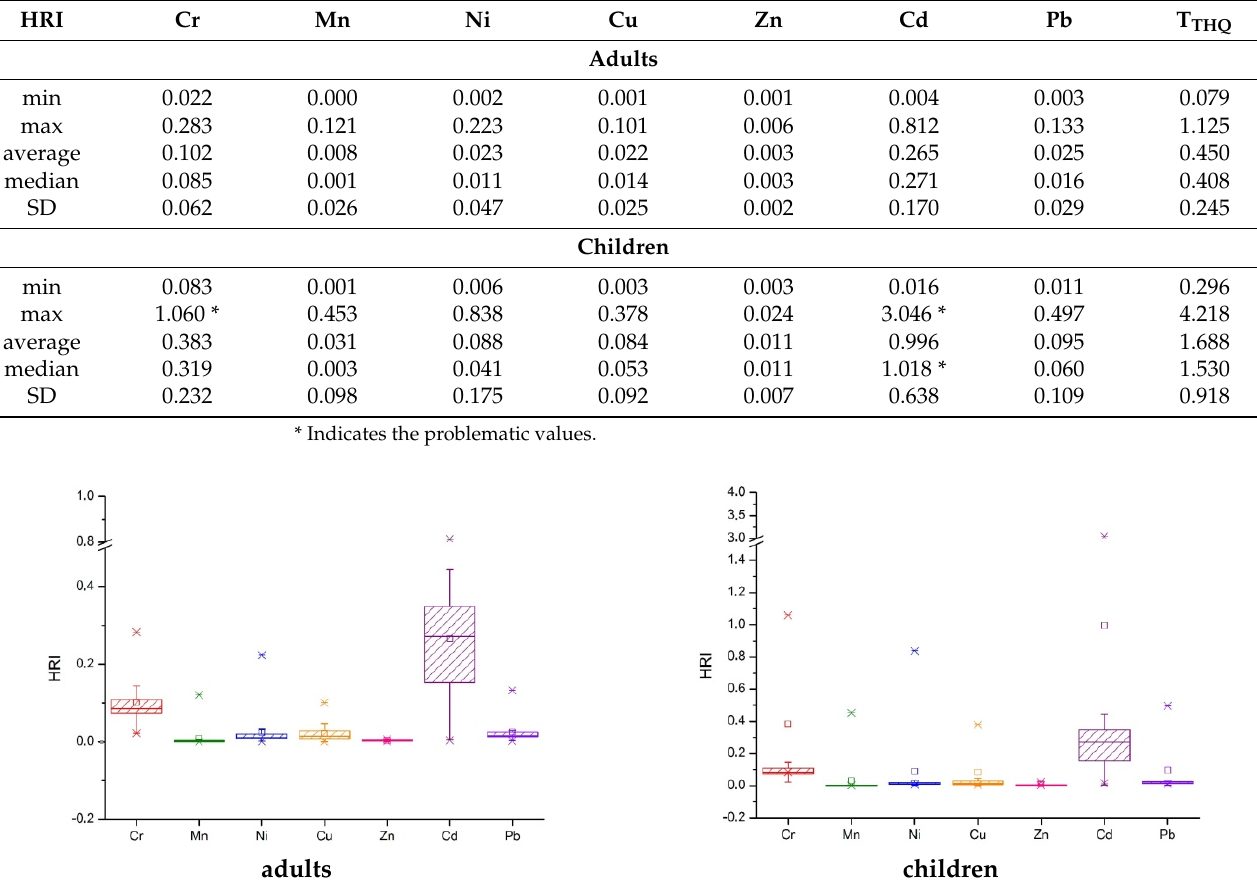
Figure 5. The health risk index represented as box-plots for seven toxic metals in well water.